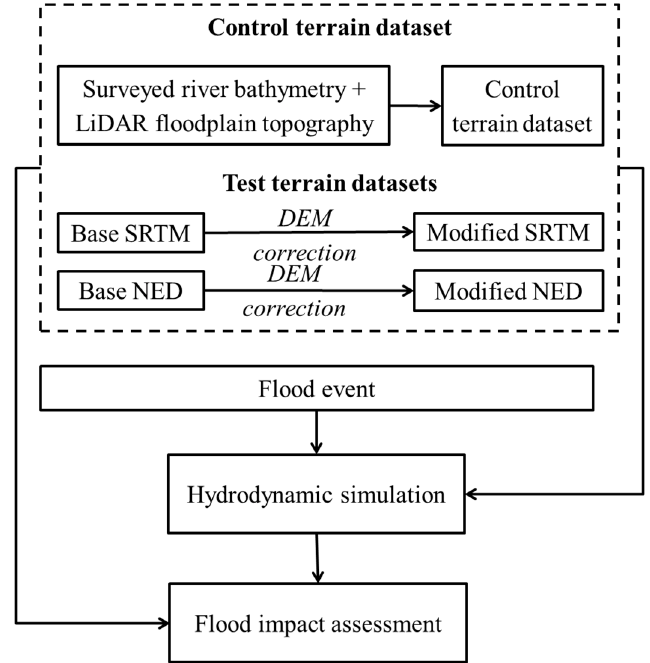
Figure 1. Methodology flowchart.